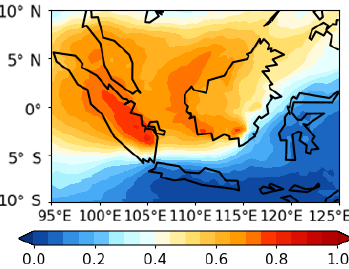
Figure 8. Fraction of simulated PM 2 . 5 concentrations originating from peat fire emissions. Simulations use the new FINNpeatSM fire emissions with surface